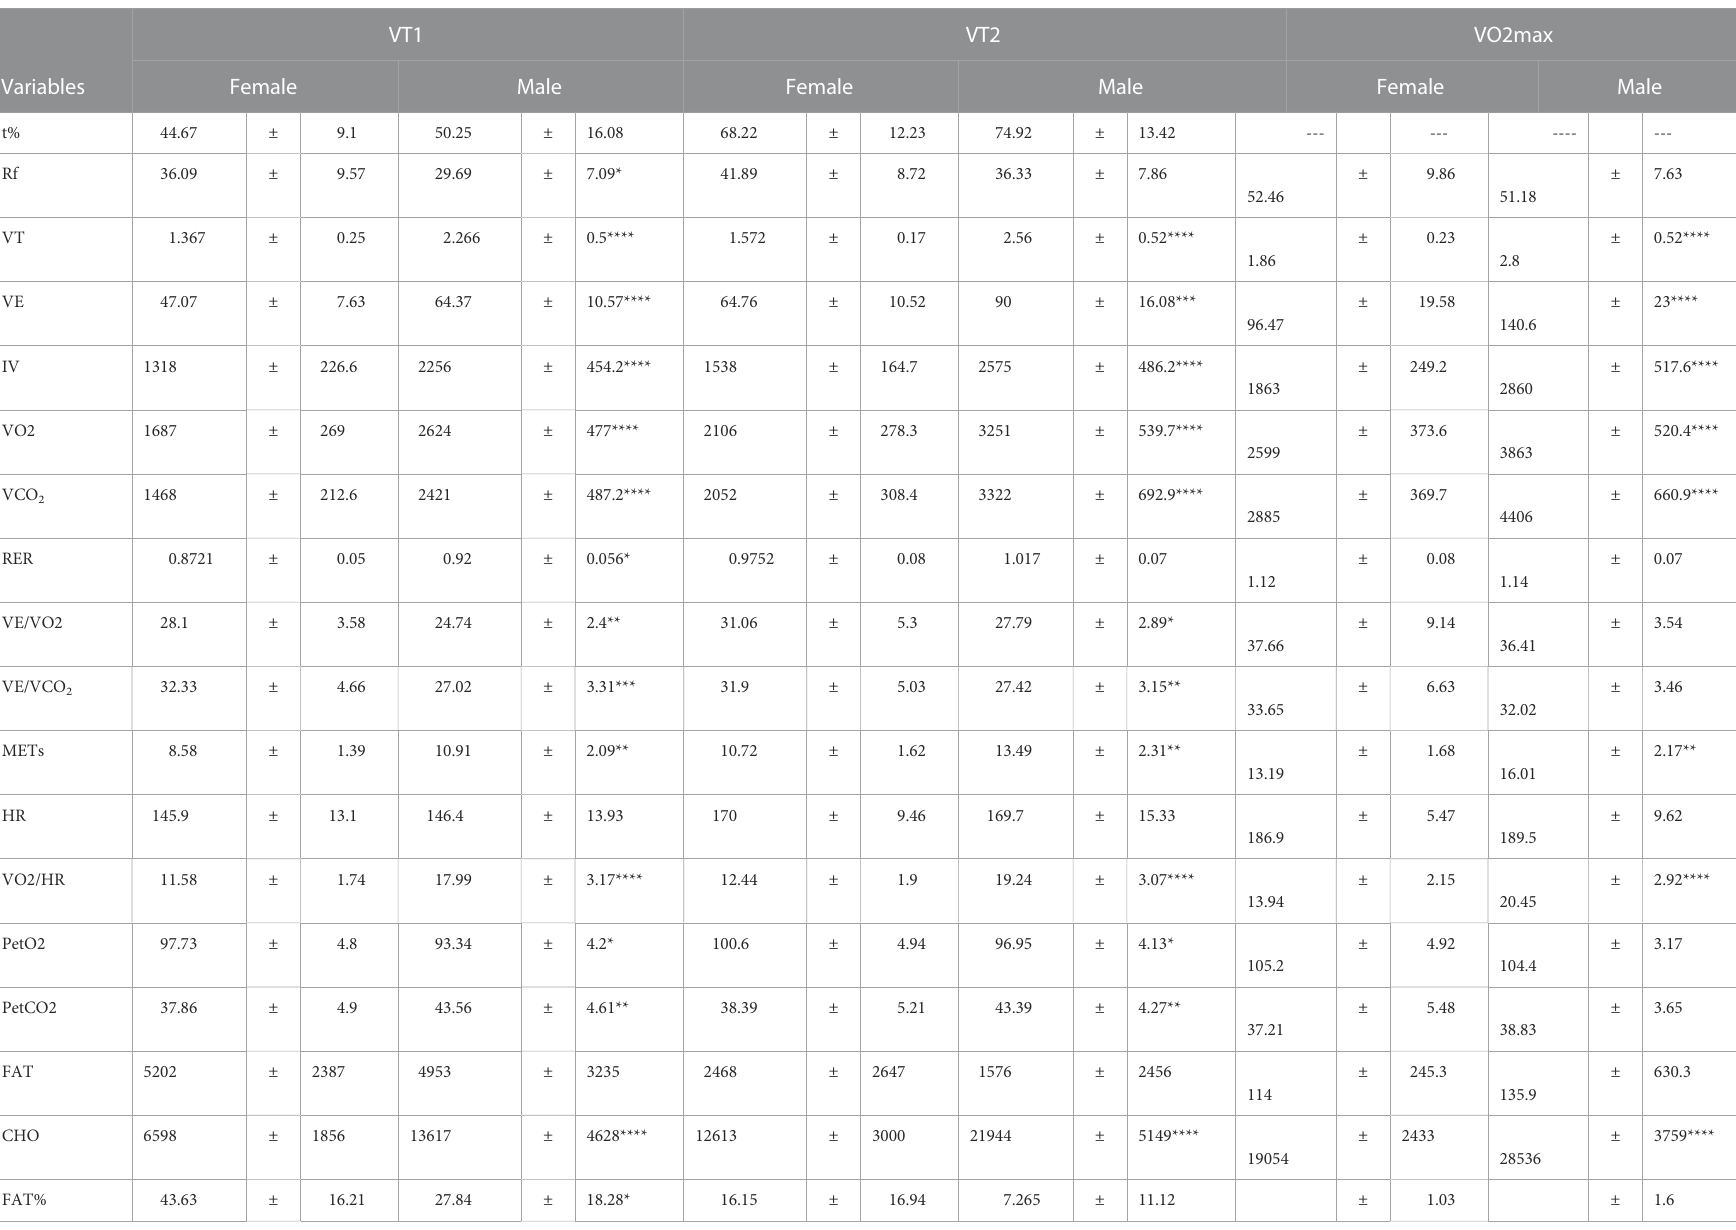
TABLE 3 Sex-related cardiopulmonary